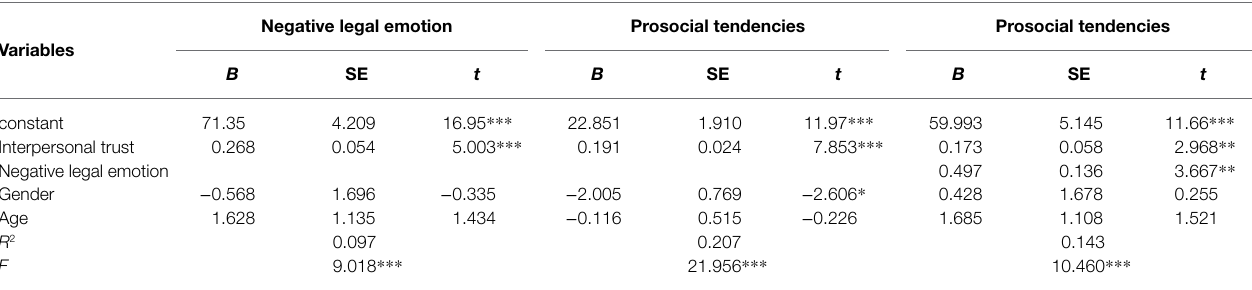
TABLE 5 | Results of multiple regression